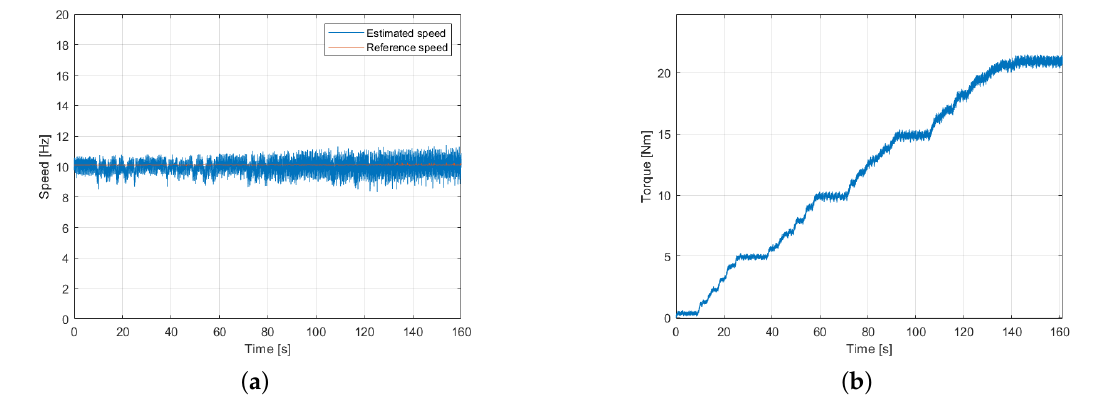
Figure 16. Loaded behaviour at 150 rpm. ( a ) Speed tracking. ( b ) Torque produced.